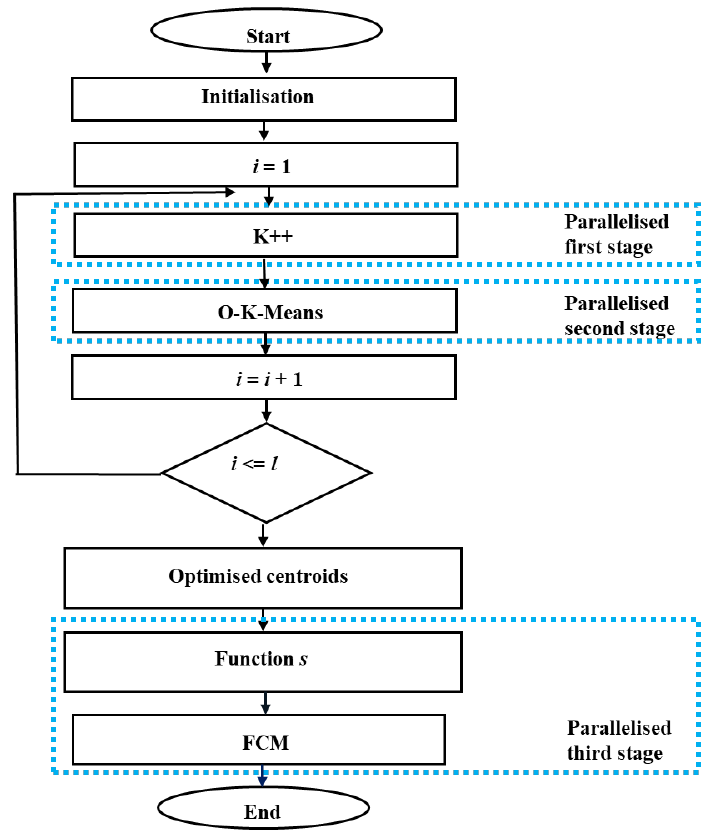
Figure 1. Parallelised implementation of POFCM algorithm.